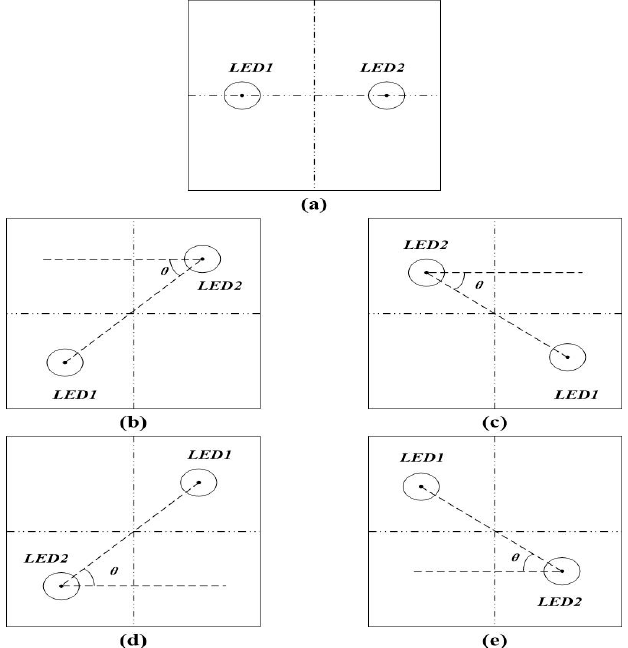
Figure 6. Different situations of the rotation angle θ : ( a ) the light and smartphone image sensor axes are the same; ( b ) the camera is rotated clockwise by θ ; ( c ) the camera is rotated counterclockwise by 180 ◦ + θ ; ( d ) the camera is rotated clockwise by 180 ◦ + θ ; ( e ) the camera is rotated counterclockwise by θ .